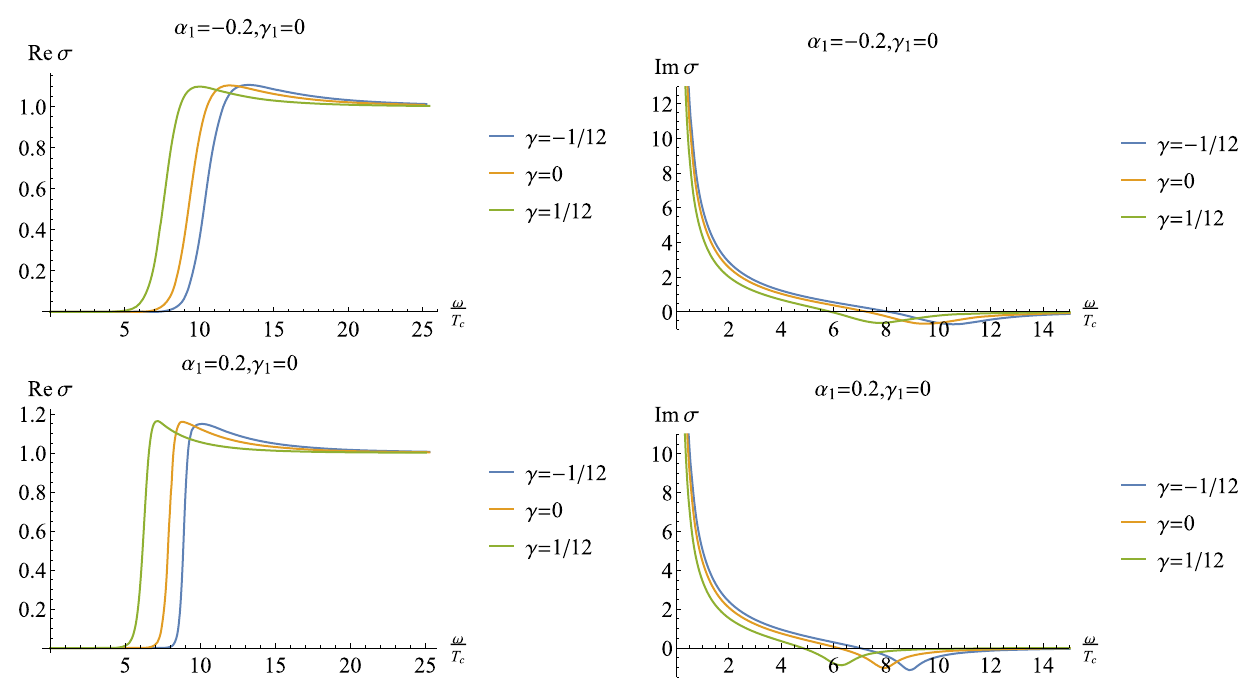
Fig. 10 Real and imaginary parts of conductivity as a function of the frequency for different α 1